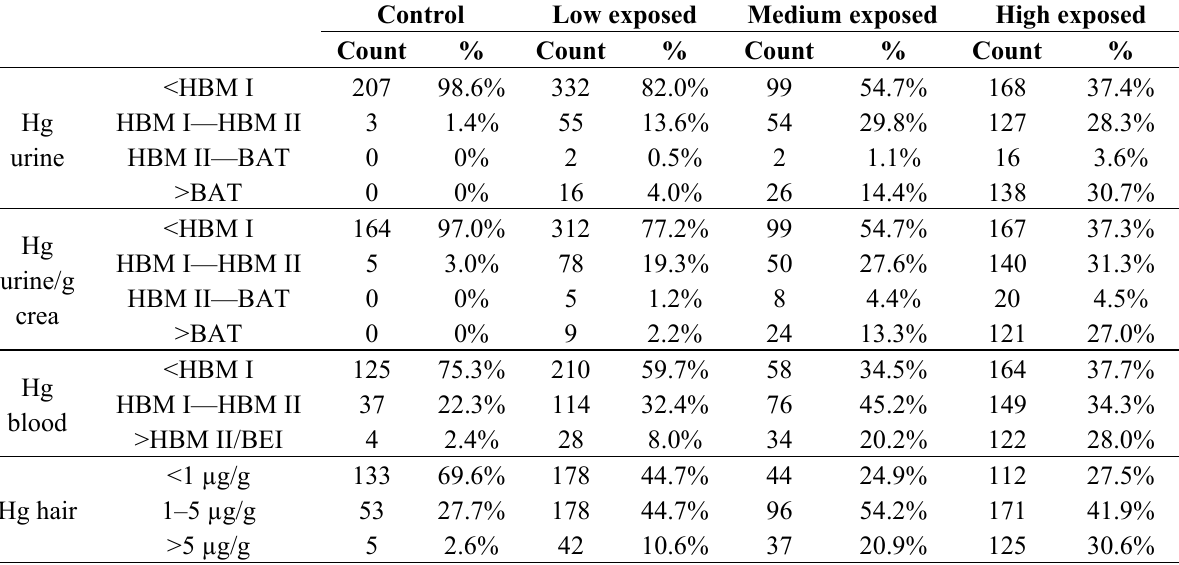
Table 5. Distribution of the mercury concentration in the human biomonitors in four exposure subgroups compared to threshold values (HBM = human biomonitoring level, BEI = biological exposure index, BAT = work place tolerance